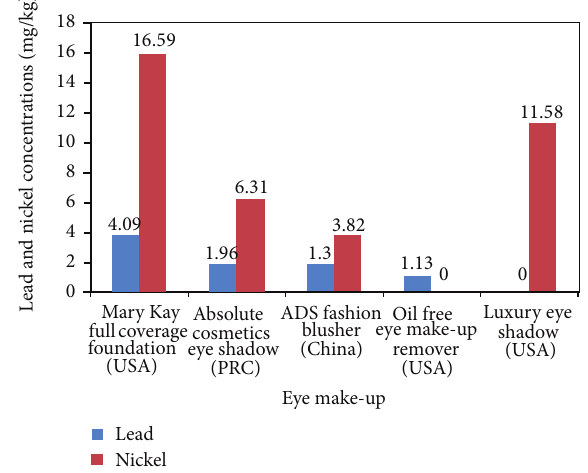
Figure 5: Lead and nickel concentrations (mg/kg) in eye make-ups. Suggested safe levels of Gondal et al. (0.5ppm), Expert Panel 2007 (0.2 ppm), and Germany (1ppm). Suggested safe levels of nickel: Gondal et al. (5ppm), Basketter et al. low limit level (1ppm), and Basketter et al. high limit level